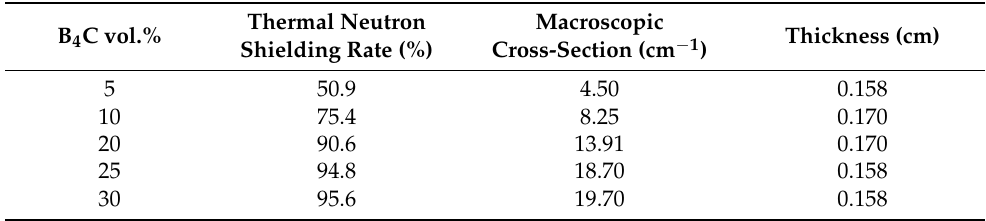
Table 3. Measured thermal neutron shielding rate and calculated macroscopic cross-section of B 4 C/Al6061 composites considering sample